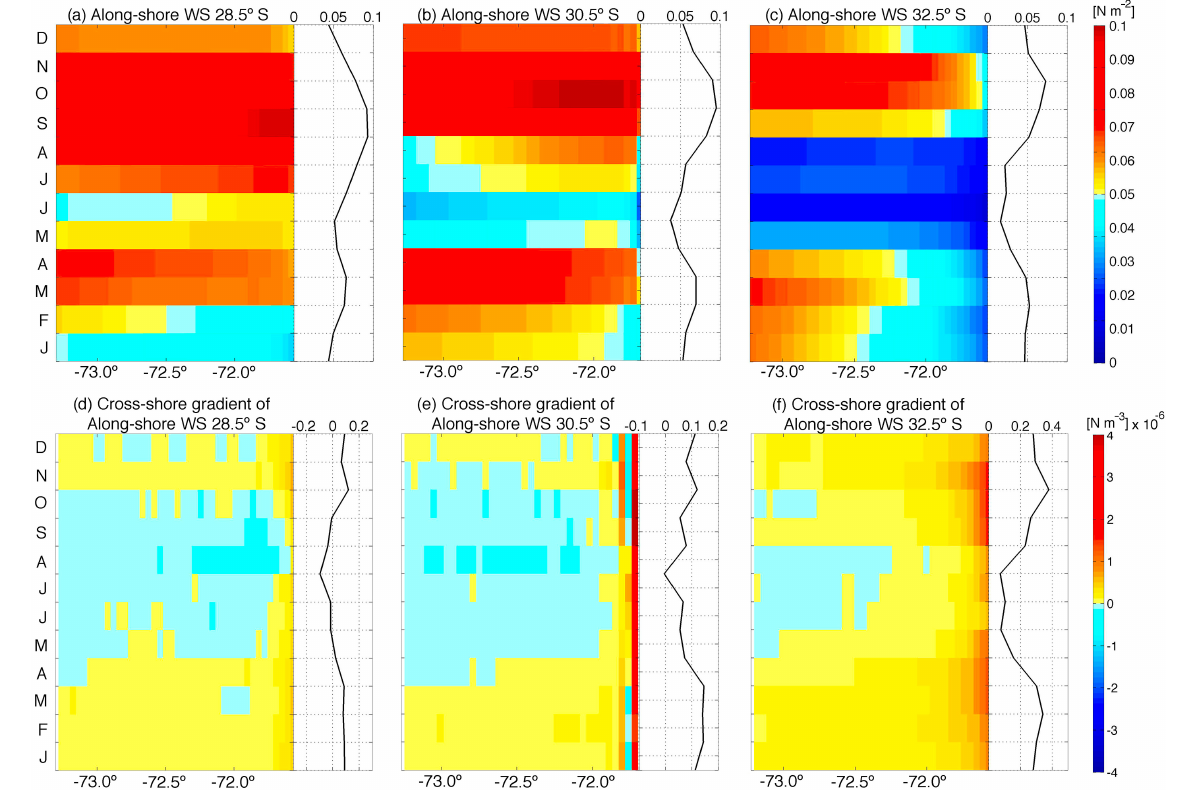
Figure 6. Hovmöller diagrams of alongshore wind stress seasonal cycle (top panels) and the zonal gradient of alongshore wind (lower panels) for the regions at 28.5 (a, d) , 30.5 (b, e) and 32.5 ◦ S (c, f) . The monthly mean zonal wind stress and mean zonal gradient are also shown (side black